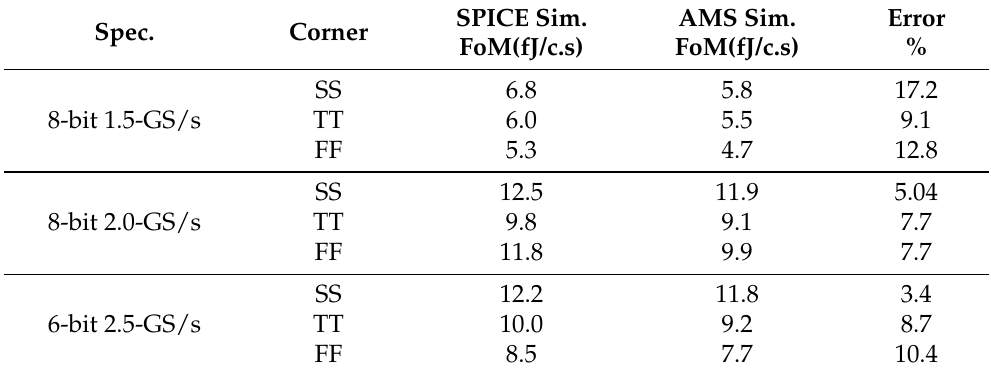
Table 8. Figure-of-merit comparisons at each target ADC specification; data from [22]. SPICE Sim. AMS Sim. Spec. Corner